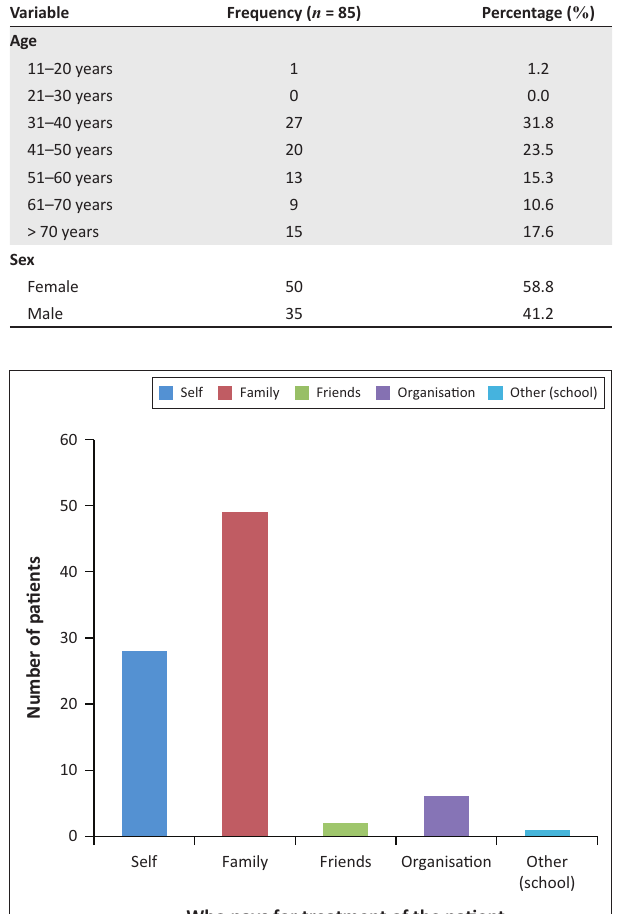
TABLE 1: Socio-demographics of